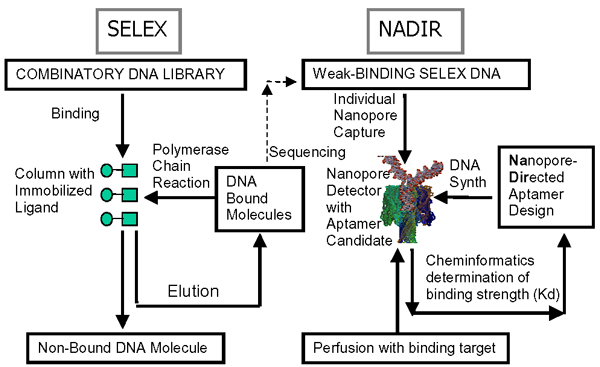
The determination of aptamers can be done (or initiated) via Systematic Evolution of Ligands by Exponential Enrichment (SELEX), as shown schematically on the left. What is proposed here is a linkage to a nanopore-detector directed (NADIR) search for aptamers that is based on bound-state lifetime measurements. NADIR complements and augments SELEX in usage: SELEX can be used to obtain a functional aptamer, and NADIR used for directed modifications (for stronger binding affinity, for example).